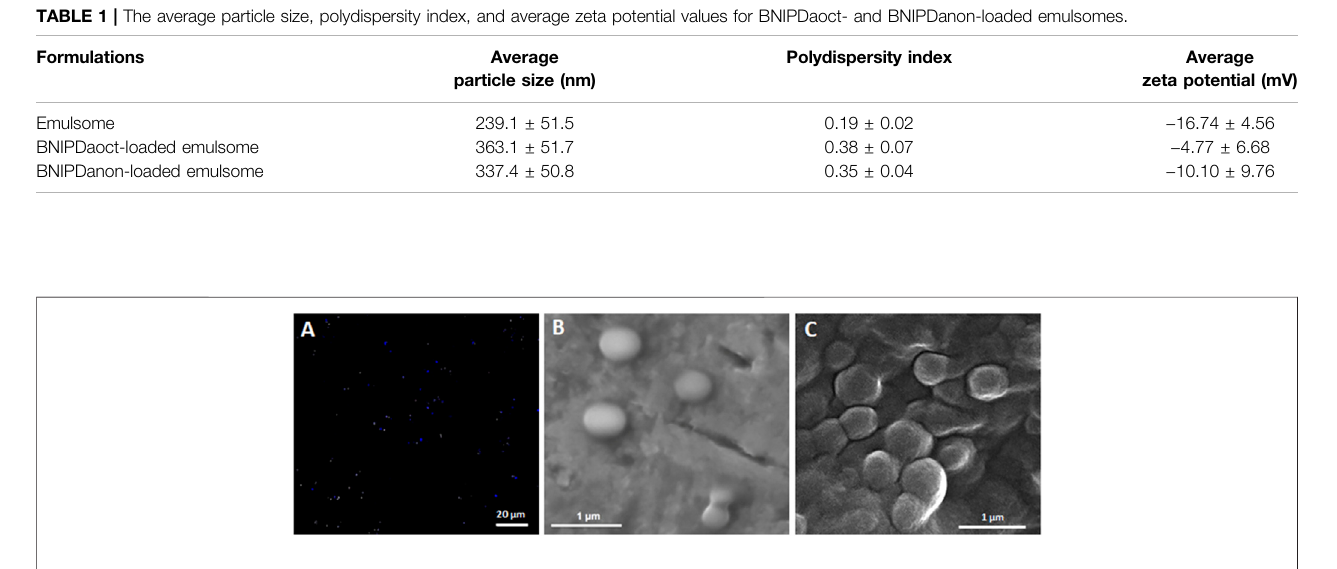
FIGURE2| Dispersity,shape,andmorphologyanalysisofemulsomes. (A) CLSMimageofBNIPDaoct-loadedemulsomes.Scalebarcorrespondsto20 µm. (B,C) SEM micrographs of BNIPDaoct- and BNIPDanon-loaded emulsomes, respectively. Scale bars correspond to 1 µm.